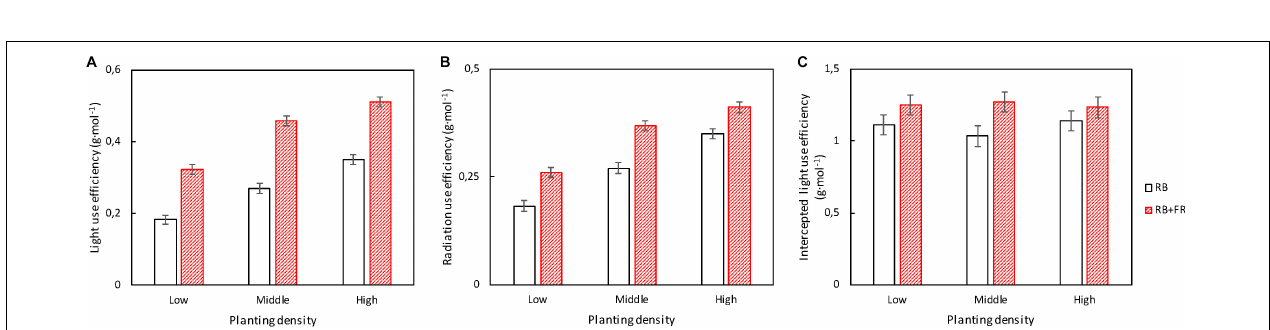
FIGURE 5 | Intercepted photosynthetic photon flux density (PPFD) of lettuce canopy grown at three planting densities (low, middle, and high being 23, 37, and 51 plants m − 2 ). Solid lines represent with far-red radiation (FR) treatment (52 µ mol m − 2 s − 1 FR) and dashed lines indicate treatment without FR. Light was cumulated from 14 to 28 DAT. Bars on top of each day represent least significant difference. Significant FR effect: ∗ P < 0.10, ∗∗ P < 0.05 and, ∗∗∗ P < 0.01. Data are means of two blocks ( n = 2) each with four–six replicate plants.